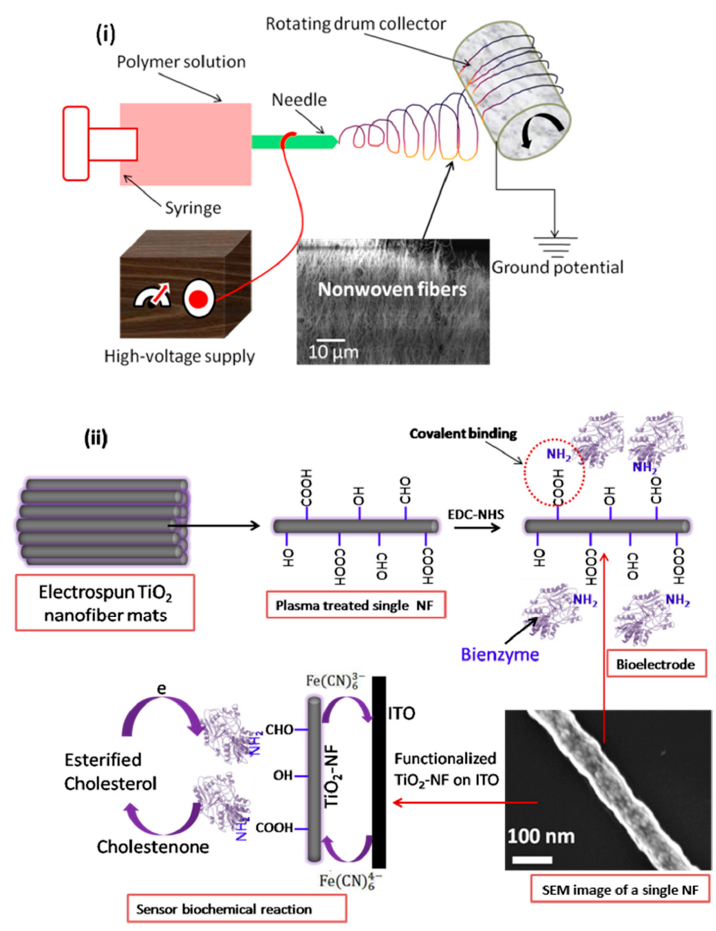
Figure 14. ( i ) Schematic illustration of the synthesis of TiO 2 nanofibers and ( ii ) biofunctionalized mesoporous TiO 2 nanofibers for esterified cholesterol detection. Reprinted with permission from [105]. Copyright (2014) American Chemical